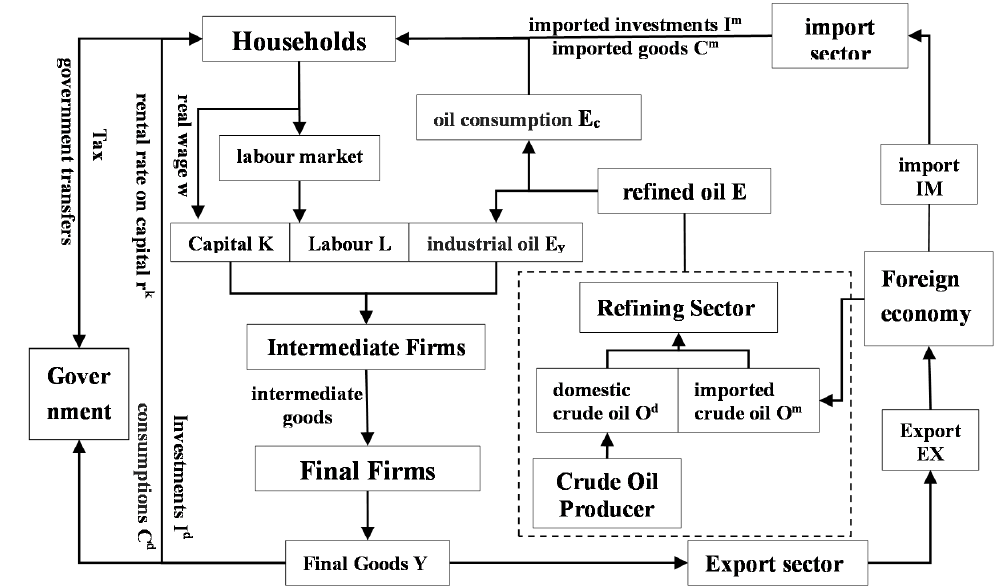
Figure 3. Basic structural relationship of the model.